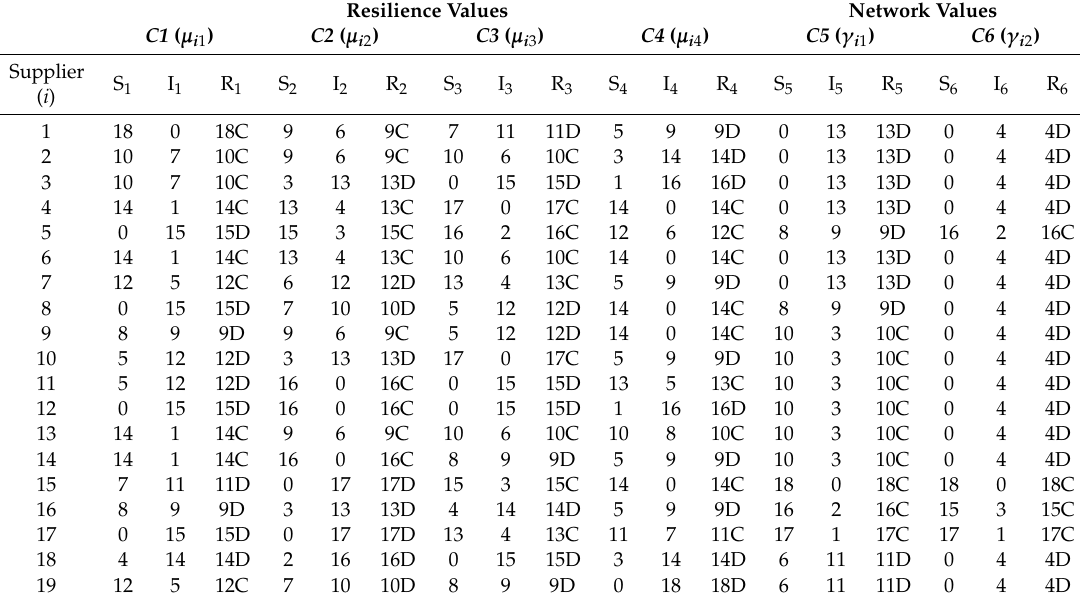
Table 2. Count matrix of S c ( a ) and I c ( a ) with results in the